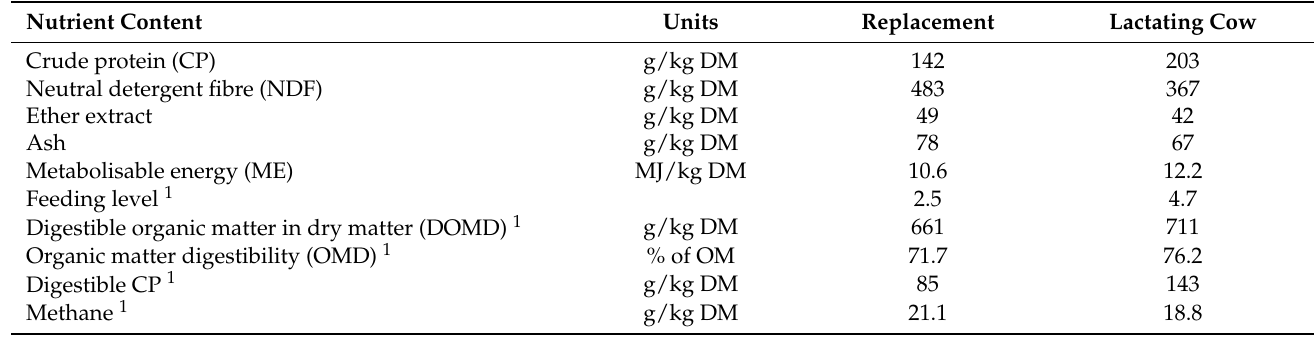
Table 4. Content and composition of the diet of a heifer replacement and lactating